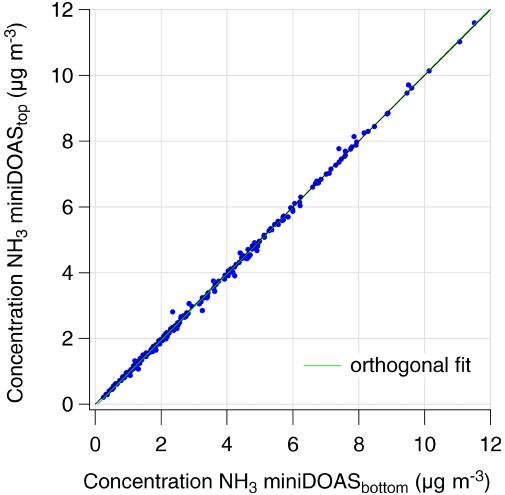
Figure 4. Scatter plot of data obtained by the two miniDOAS instru- ments during all three cross-periods. Data were filtered to include only obstacle-free wind directions and turbulent conditions ( u ∗ > 0 . 1ms − 1 ). Using an orthogonal fit, an offset of 0 . 07 ± 0 . 01µgm − 3 and a slope of 1 . 009 ± 0 . 002 (the green line) were found.